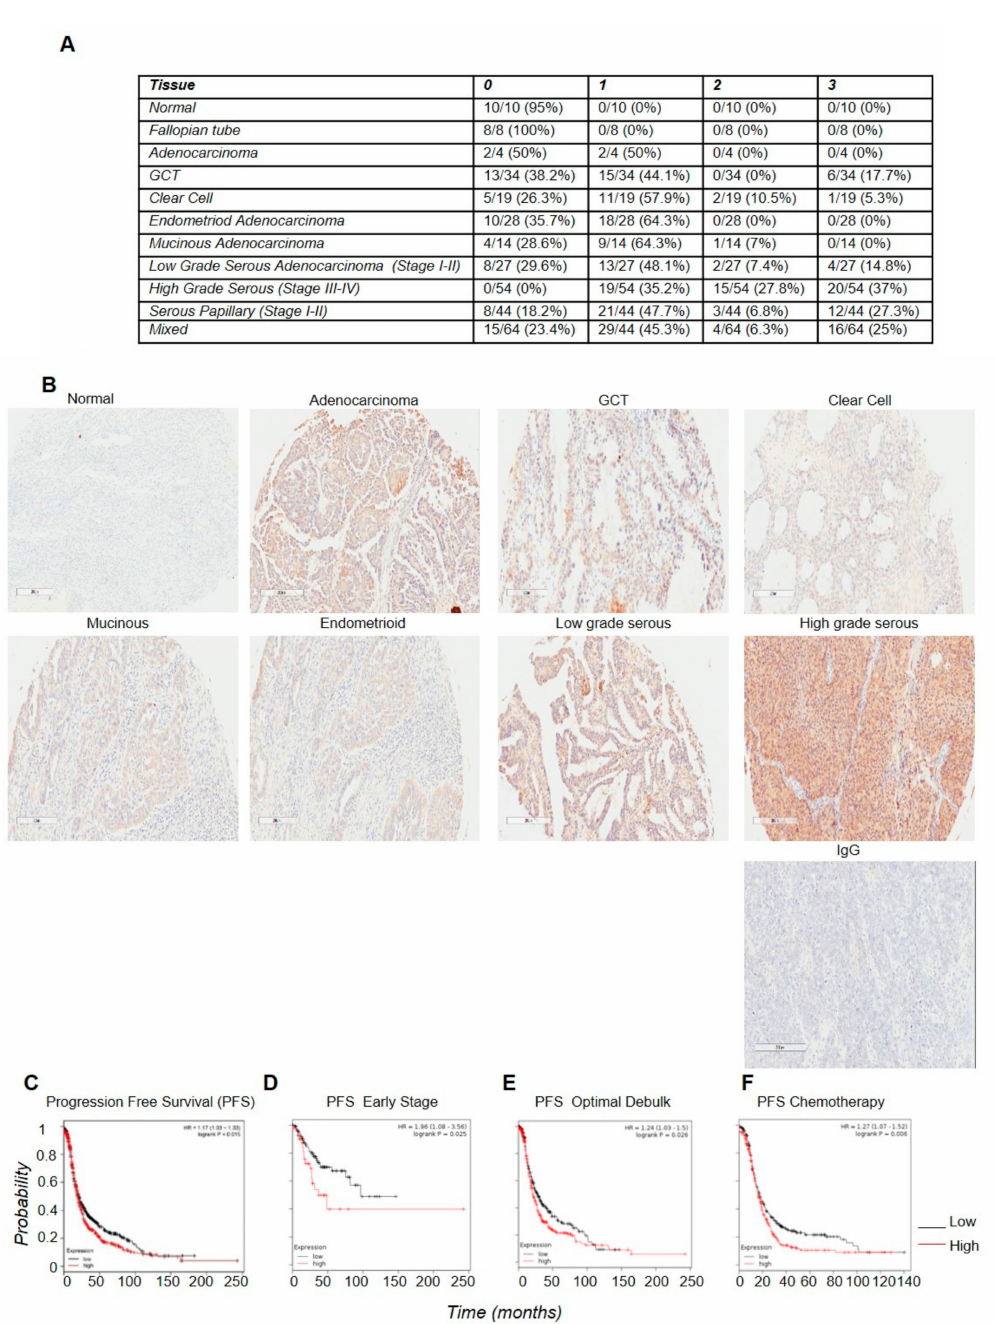
Figure 6. ( A ) Table of the immunohistochemical assessment of KRT14 expression in ovarian cancer tissue microarrays. Staining intensity was scored according to 0 (no stain), 1 (low), 2 (medium), or 3 (high). ( B ) Representative immunohistochemical staining of KRT14 in the various ovarian cancer subtypes (as labelled in figure) from TMA assessments. Scale bar = 200 µ m. ( C – F ) Association of KRT14 expression with progression-free survival (PFS) according to ( C ) overall PFS (HR 1.17; 95% CI 1.03–1.33 p < 0.015; B); ( D ) early stage (I / II) diagnosis (HR 1.96; 95% CI 1.08–3.56 p < 0.025); ( E ) following platinum and taxol-based chemotherapy (HR 1.27; 95% CI 1.07–1.51 p < 0.006); and ( F ) following optimal debulk (HR 1.24; 95% CI 1.03–1.5 p <